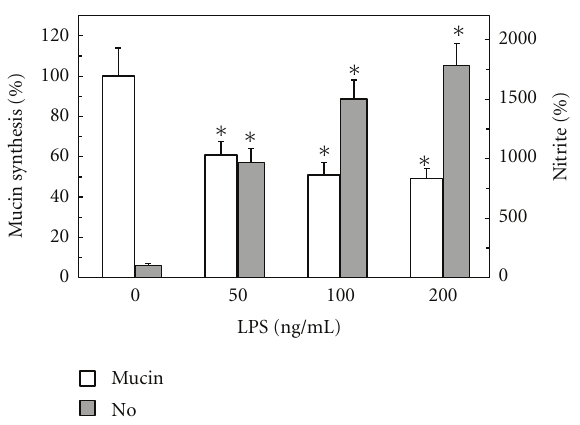
Figure 1: E ff ect of P. gingivalis LPS on mucin synthesis and nitrite production in rat sublingual salivary gland acinar cells. The cells were treated with the indicated concentrations of the LPS and incubated for 16h in the presence of [ 3 H]glucosamine used as a marker of mucin synthesis. Values represent the means ± SD of five experiments. ∗ P < . 05 compared with that of control (LPS − 0).